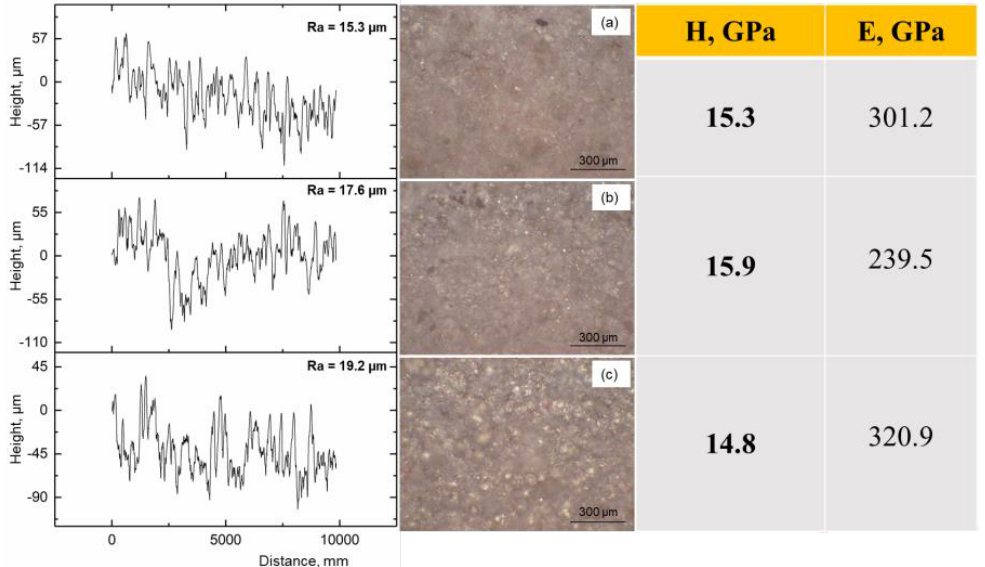
Figure 4. Results of the hardness and modulus of elasticity as well as micrographs and surface roughness of multilayer gradient coatings: ( a ) three-layer, ( b ) five-layer, ( c ) six-layer.